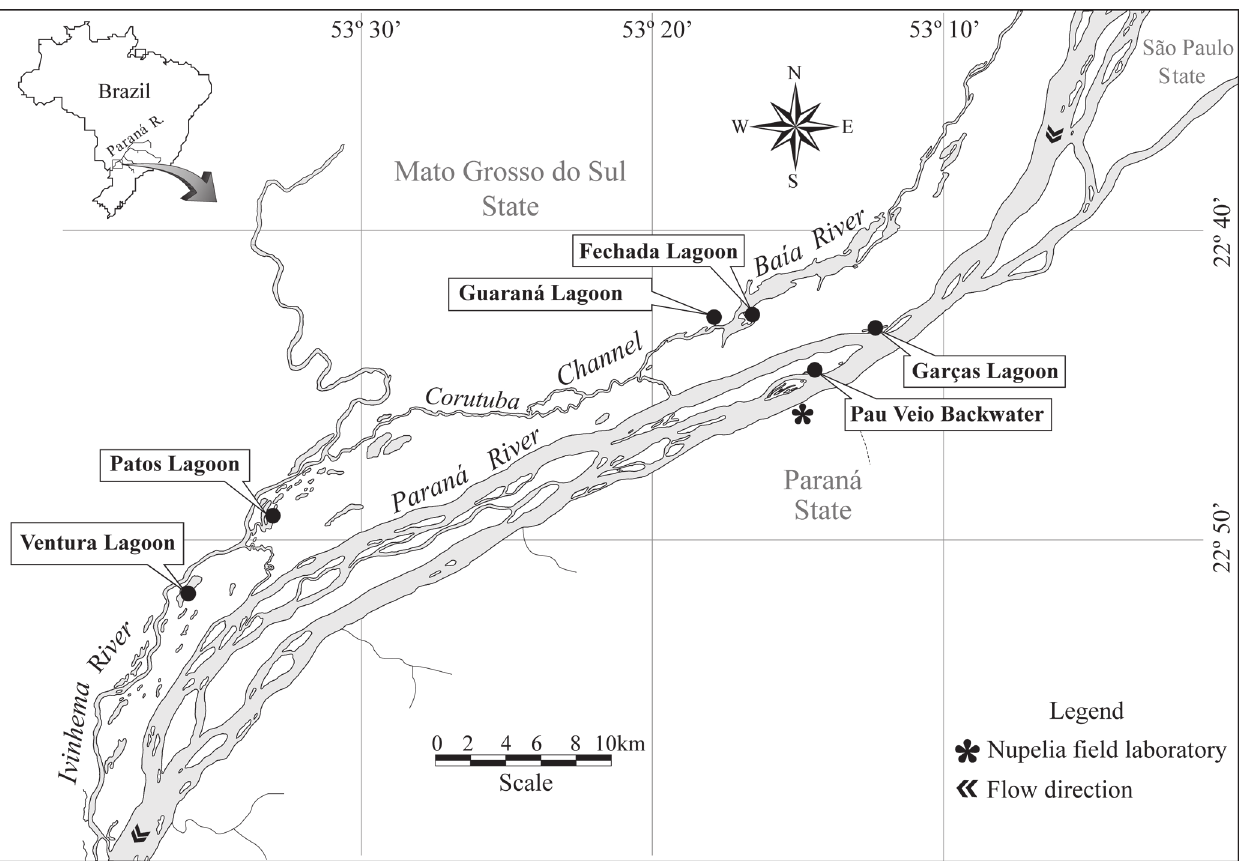
FIGURE 1 | Protected areas and sampling stations in the upper Paraná River floodplain. Paraná River (highly altered – HA), Baía River (moderately altered – MA), and Ivinhema River (less altered –